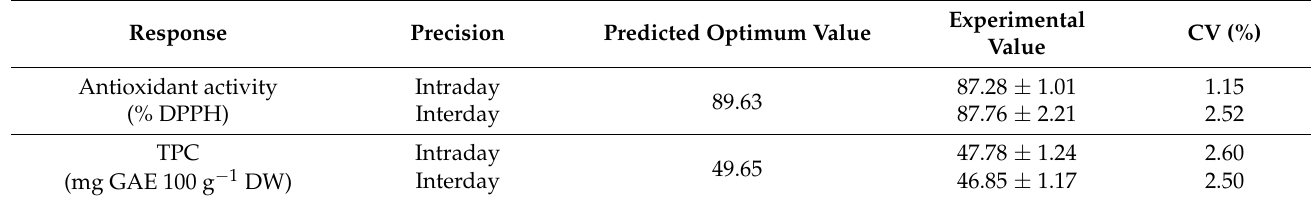
Table 3. The predicted and experimental value of the optimum